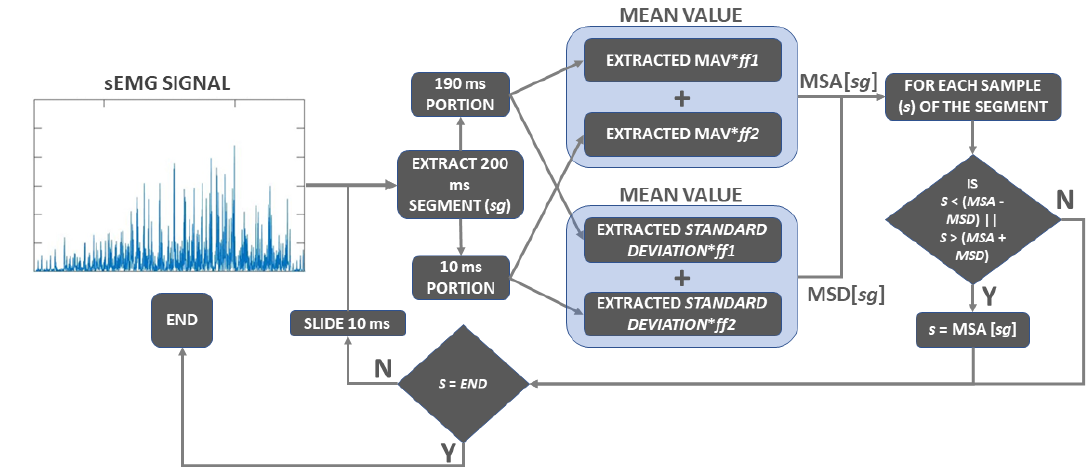
Figure 3. The main block diagram for the Antonyan Vardan Transform (AVT) filter where samples s out of the range Mean Signal Amplitude ( MSA ) ± Mean Signal Deviation ( MSD ) are substituted by the MSA value of the signal. sEMG, surface